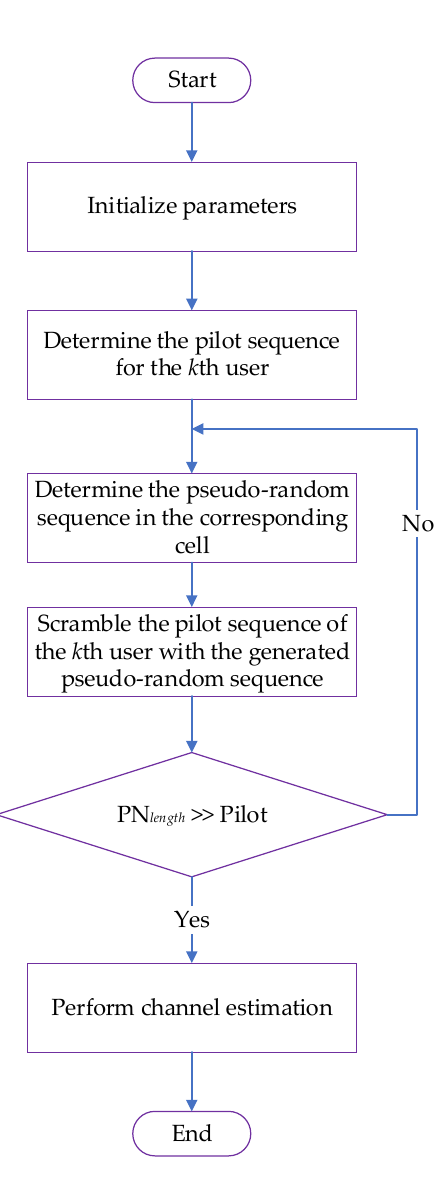
Figure 6. Proposed pseudo-random algorithm flowchart.